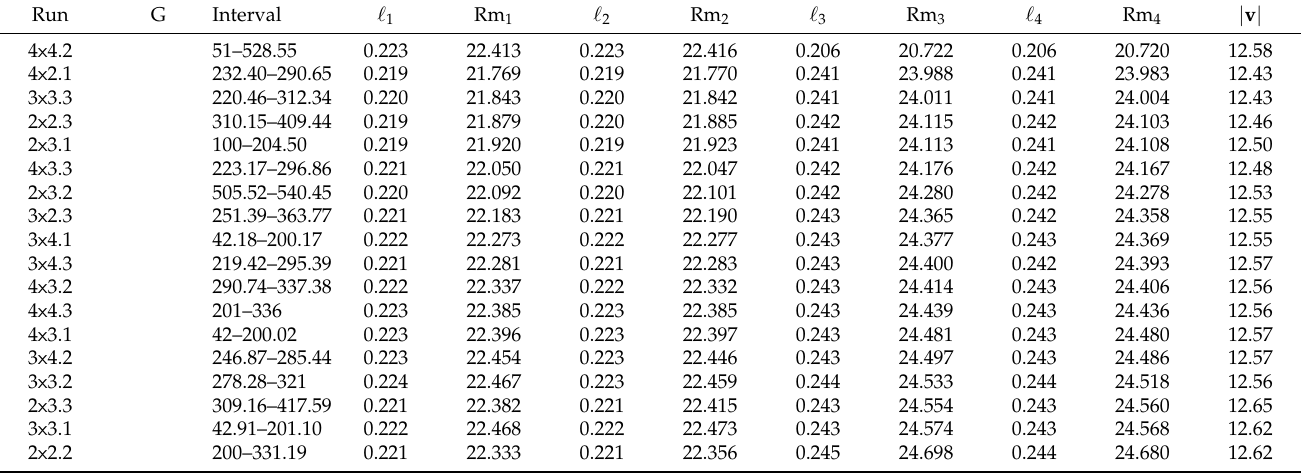
Table 3. Magnetic Reynolds number estimates in the runs for M i ≤ 4 (in the order of increasing Rm 4 ). Column G: “M” indicates that magnetic field generation is sustained in the perturbed regime; Interval: the time interval, over which the magnetic Reynolds number estimates are computed; (cid:96) n : estimates (7) of the internal spatial scale of the perturbed regime; Rm n : the magnetic Reynolds number estimate based on (cid:96) n ; | v | : the characteristic flow velocity in the time interval under